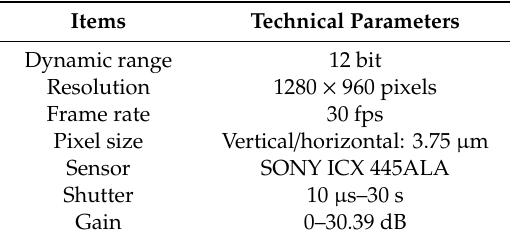
Table 1. The technical parameters of the DMK 33G445.